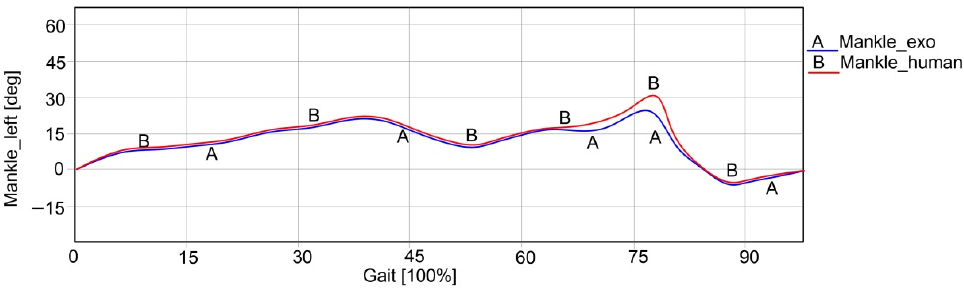
Figure 34. Left ankle angular variation exoskeleton vs. human subject during a complete gait.